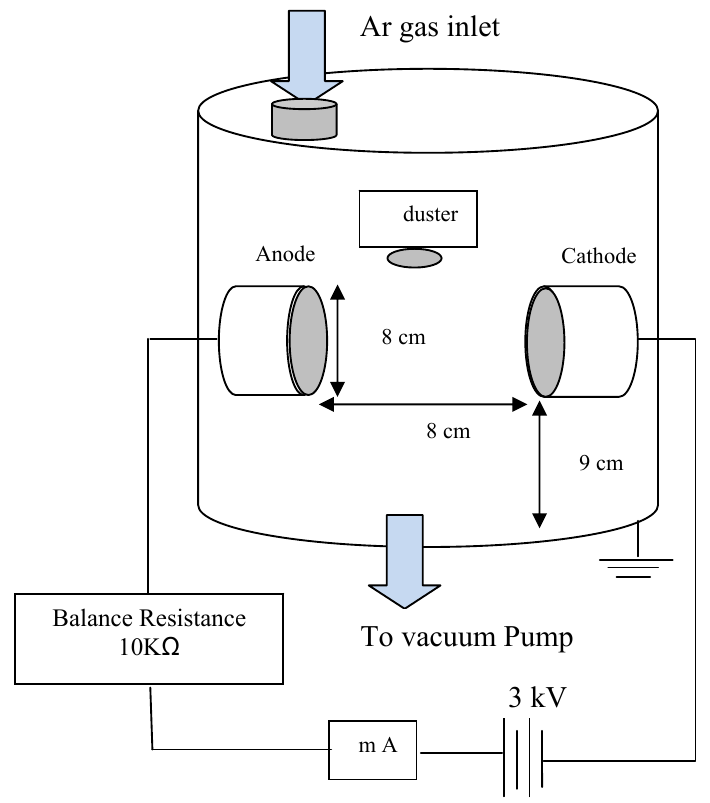
Fig. 1: Schematic the diagram of vacuum chamber with electric